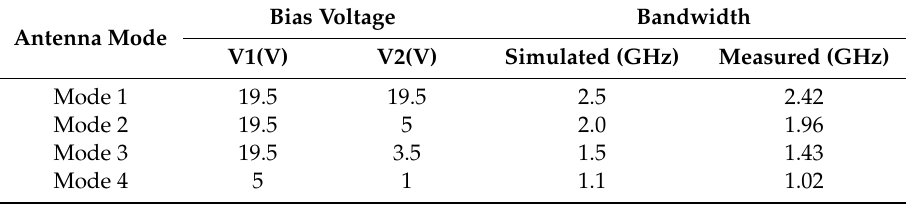
Figure 8. The measured frequency response of the proposed antenna. Table 4. Comparison of bandwidth between the simulation and measurement.